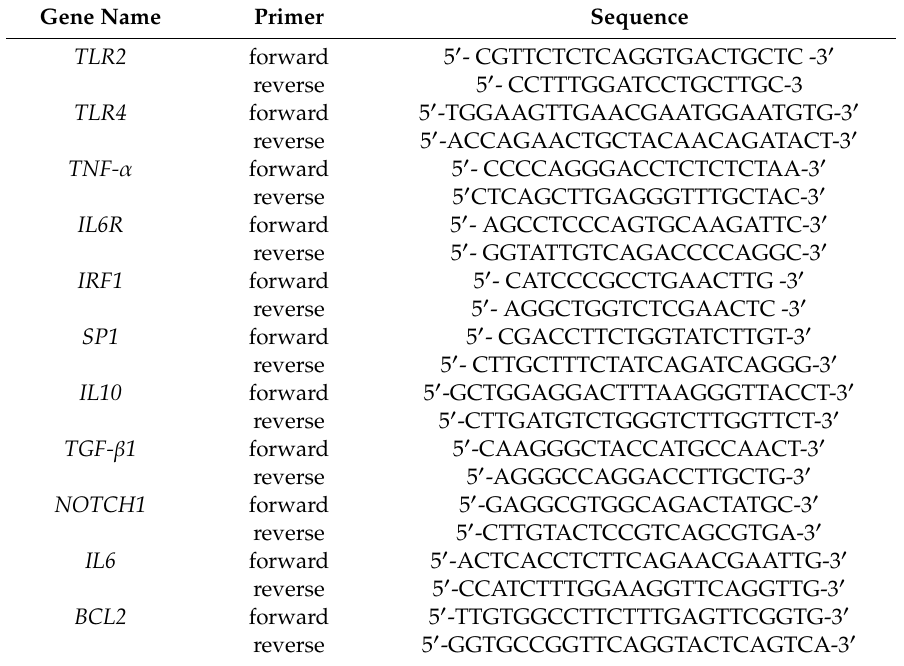
Table 2. Primer sequences used in the quantitative reverse-transcriptase polymerase chain reaction